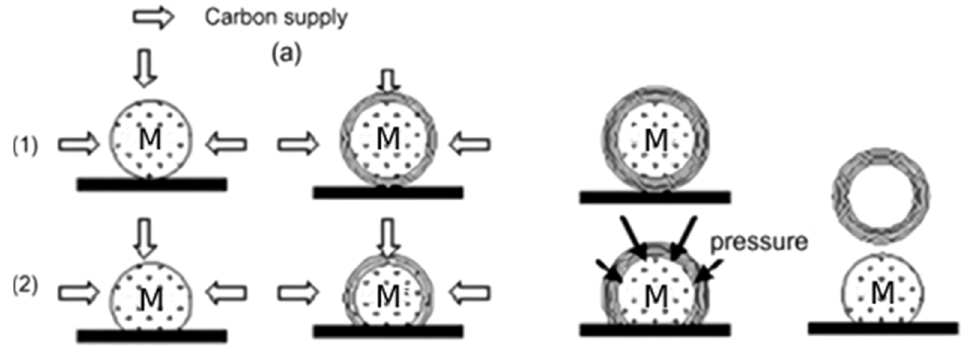
Figure 22. Schematic diagram of another growth mechanism of CNOs. (1) CNOs with the metal core. (2) CNOs with an empty core [93].